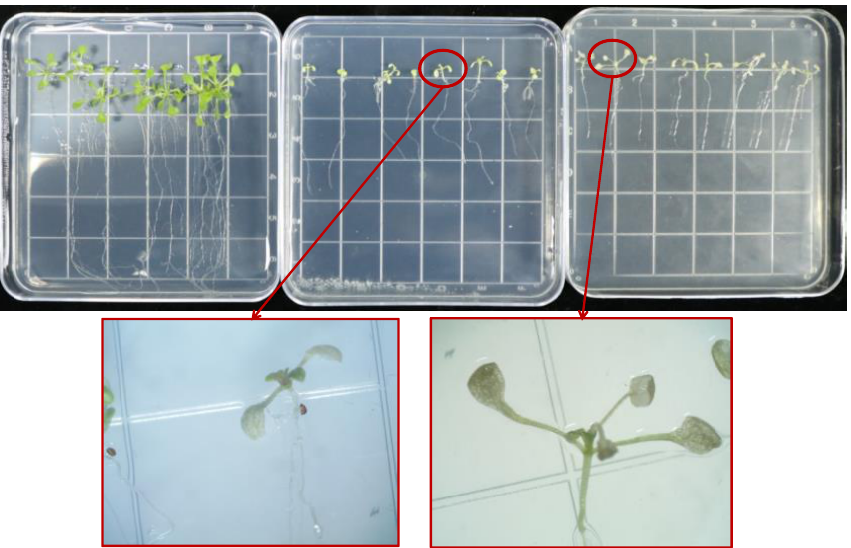
Figure 8. Photographs illustrating seedling phenotype of Arabidopsis thaliana treated with APD-II-15 and atrazine.